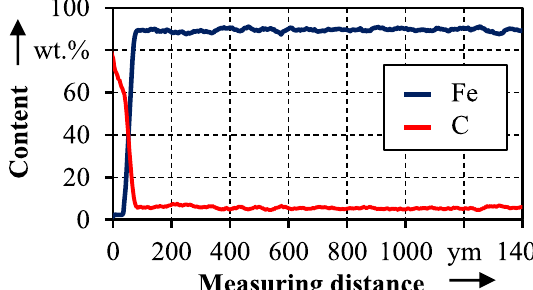
Fig. 9. Iron and carbon content of graphite-coated samples determined via EDX line measurement.